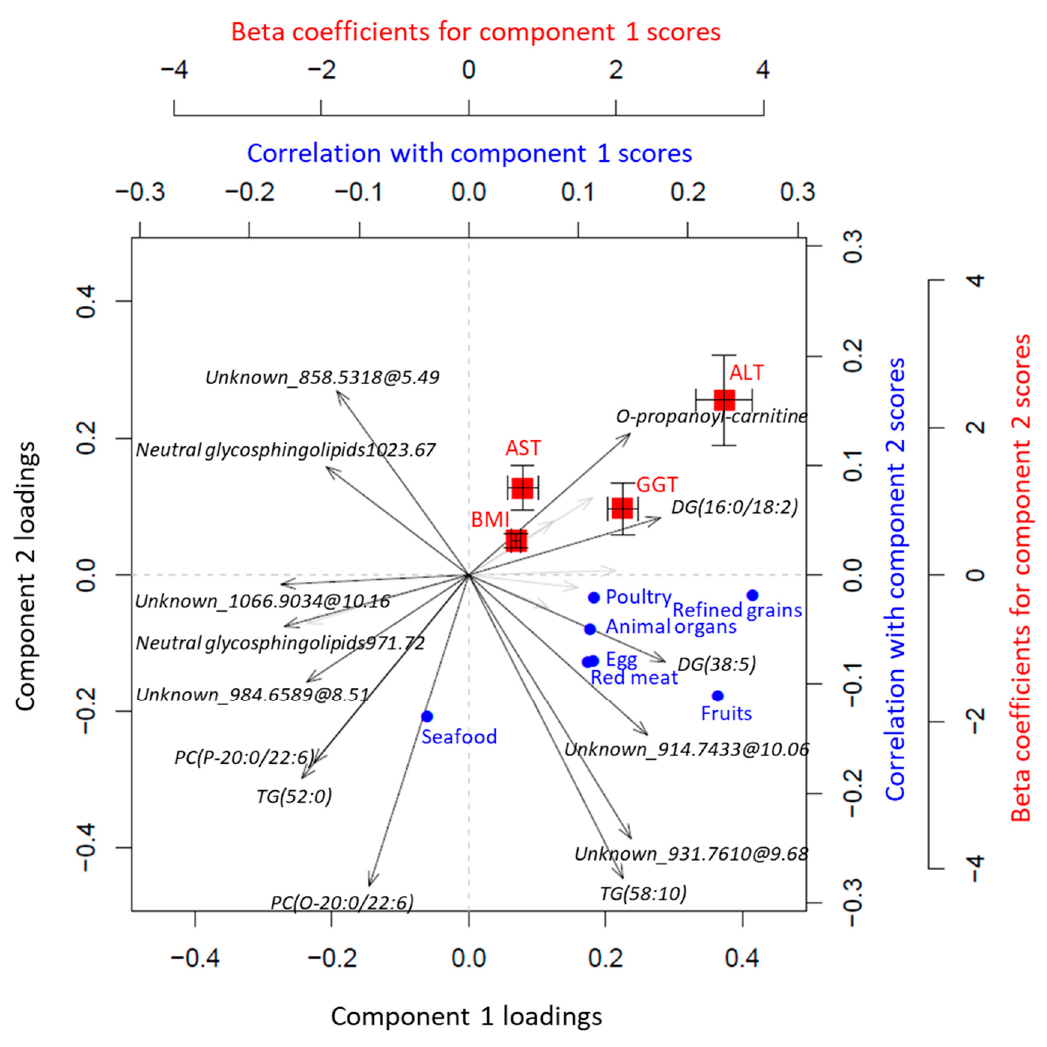
Figure 4. A PCA-based triplot visualizing the inter-correlations between plasma metabolites predicting BMI, dietary intake variables, and metabolic traits, after adjusting for age and gender. Correlations between PCA components and dietary intakes estimated from food frequency questionnaires were calculated using the partial Spearman method. Associations of PCA components with metabolic traits were assessed using linear regression. Only metabolite feature loadings > 0.25, significant correlations, as well as correlations with animal derived foods and metabolic traits with strongest associations are shown. ALT: alanine aminotransferase; AST, aspartate aminotransferase; GGT: gamma-glutamyltransferase.